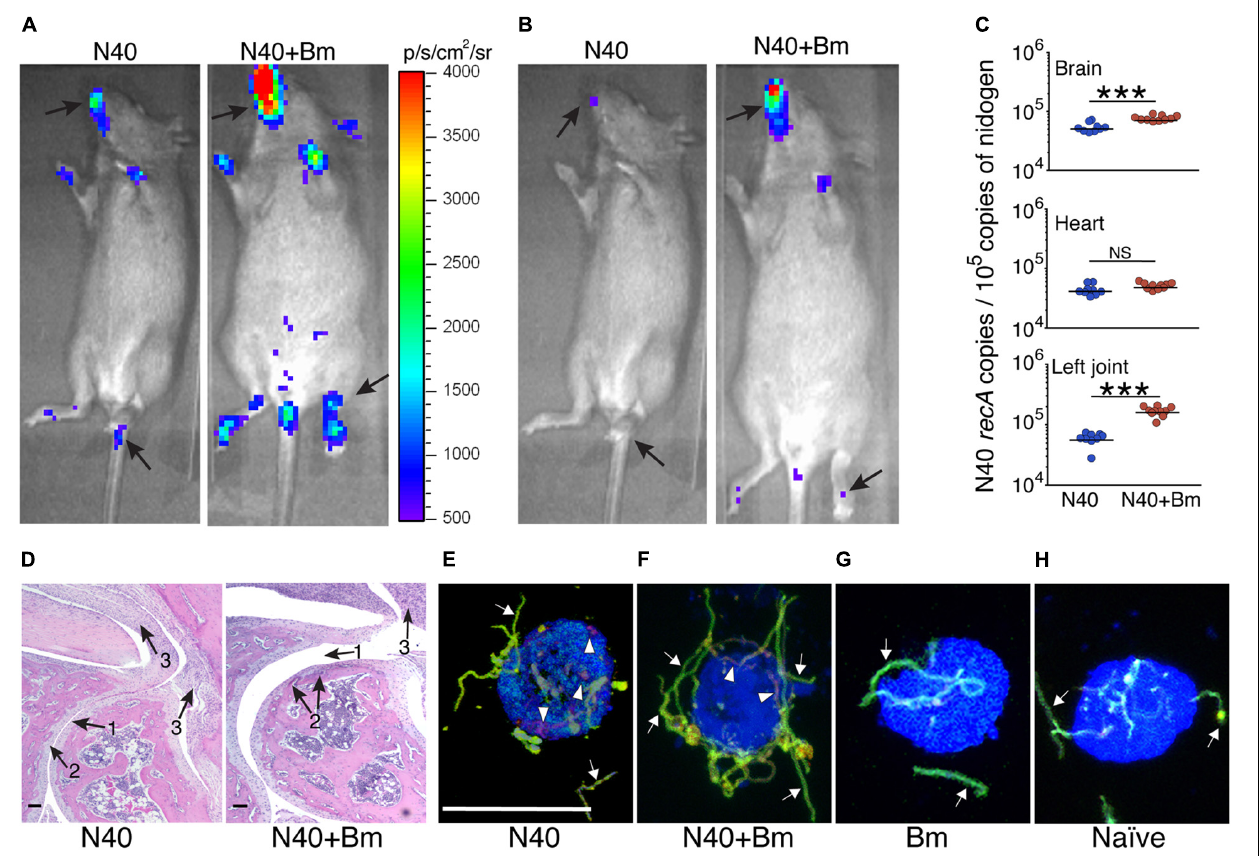
FIGURE 8 | Increased colonization of organs by N40 and exacerbation of Lyme disease in mice by co-infection with B. microti ( Bm ). (A) Representative real-time images using IVIS-200 displaying higher spirochetal burden in co-infected than N40-infected mice at 2 weeks, and (B) 3 weeks of infection. (C) Burden of N40 in tissues determined using duplex qPCR assay with horizontal lines representing the mean N40 recA copy number. Joint and brain of co-infected mice showed significantly ( ∗∗∗ p < 0.001) higher spirochete burden as compared to mice infected with N40 alone while B. burgdorferi burden in hearts was not significantly different (NS). (D) More severe arthritis manifested by change in synovial space (arrow 1), synovial hyperplasia and erosion of cartilage (arrow 2), and higher lymphocytic infiltration (arrow 3) were observed in co-infected mice as compared to the N40-infected mice. (E) Opsonophagocytosis of N40 by mouse J774.1 macrophages was observed after 2 h of co-incubation of plasma from N40-infected mice with spirochetes such that macrophages showed significant phagocytosis detected as red, internalized bacteria (arrowheads) and some green extracellular spirochetes (arrows). The macrophages are marked blue. (F) Although phagocytosis occurred after opsonization of N40 with plasma from co-infected mice, it showed significantly lower internalized spirochetes compared to those using plasma from N40-infected mice (E) . (G) Incubation of B. burgdorferi using plasma from B. microti infected mice, and (H) uninfected, naïve mice showed no phagocytosis of the spirochetes after 2 h of co-incubation of B. burgdorferi with macrophages. Bar represents 100 µ m in Figures 7E–H